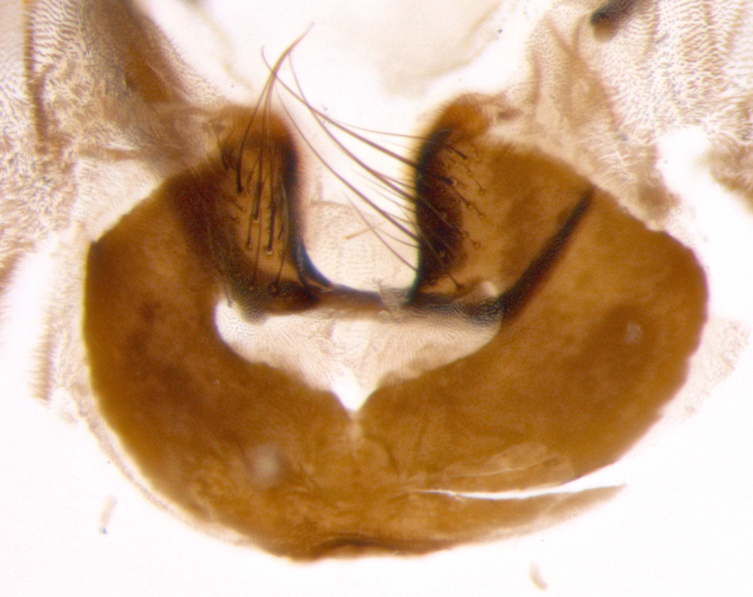
sternite 5, ventral view